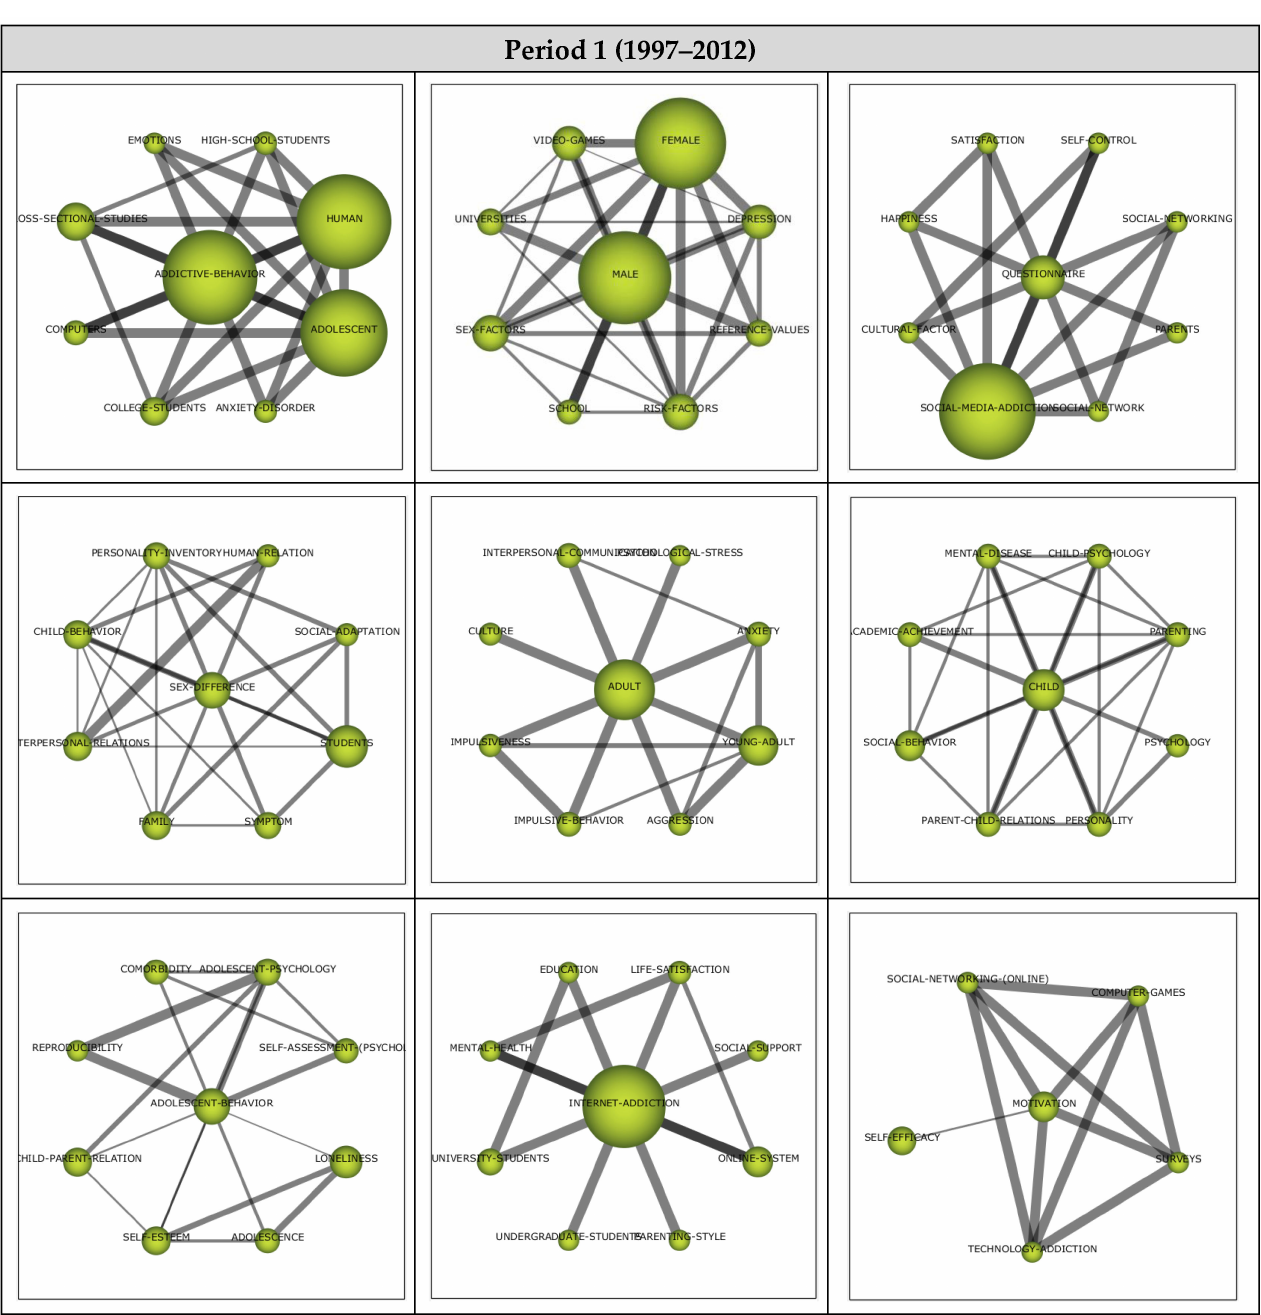
Figure 5. Period 1: Thematic network